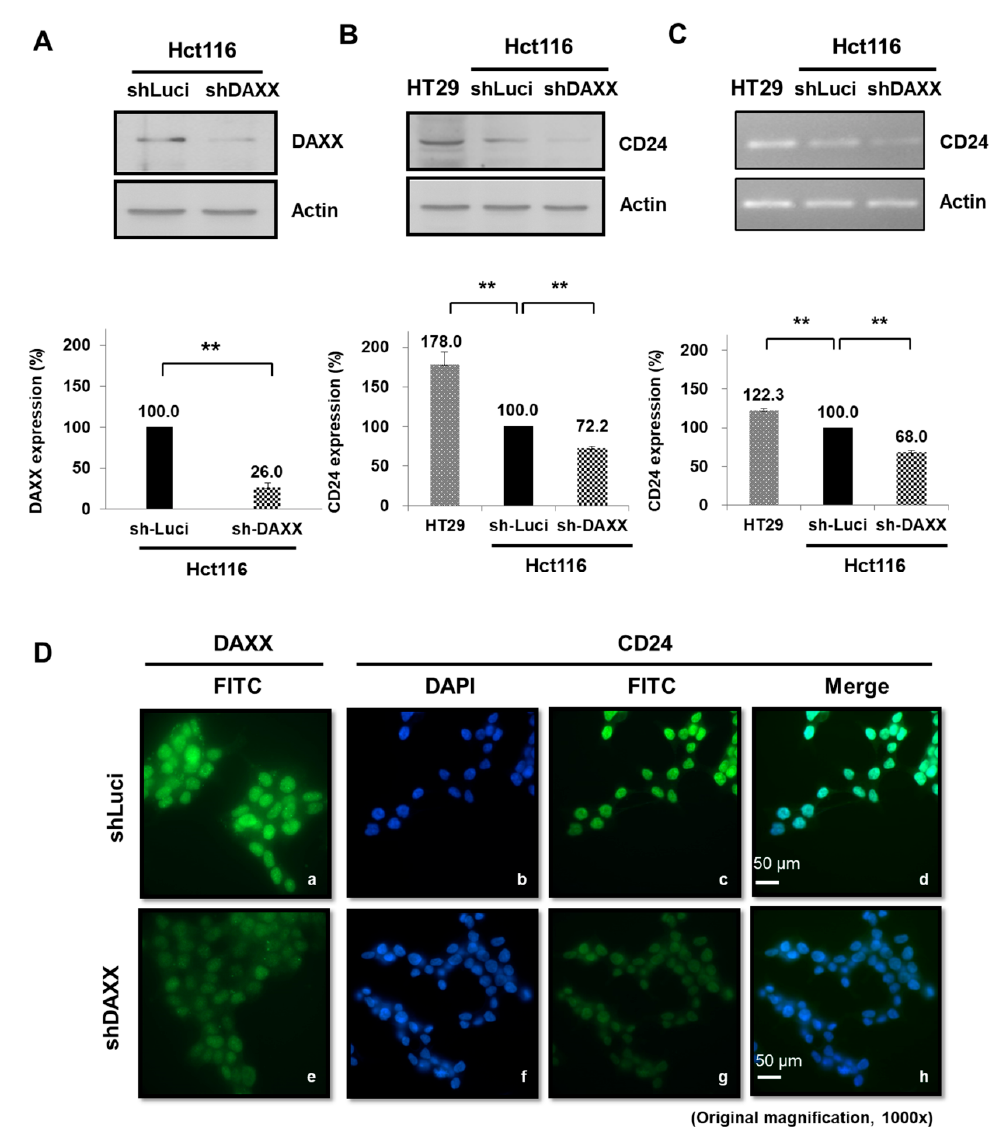
Figure 4. DAXX expression was low in Hct116 cells and was correlated with the downregulation of CD24 expression. ( A ) DAXX expression decreased after DAXX knockdown by using shDAXX. Luciferase-knockdown CRC cells was used as the control. CD24 ( B ) protein and ( C ) CD24 mRNA expression decreased in DAXX-knockdown cells at a level lower than luciferase-knockdown Hct116 cells (negative control) and HT29 cells (positive control) according to WB and RT-PCR results, respectively. β -actin was the internal control. ** p < 0.005, Student t test; n.s. = nonsignificant. ( D ) Immunofluorescence analysis indicated nuclear DAXX localization (green), which could be regulated using shDAXX: DAXX expression (green) decreased in DAXX-knockdown cells. CD24 localization did not change in DAXX-knockdown Hct116 cells. Only nuclear staining of CD24 expression (green) significantly decreased in DAXX-knockdown Hct116 cells. DAPI was the nuclear stain.